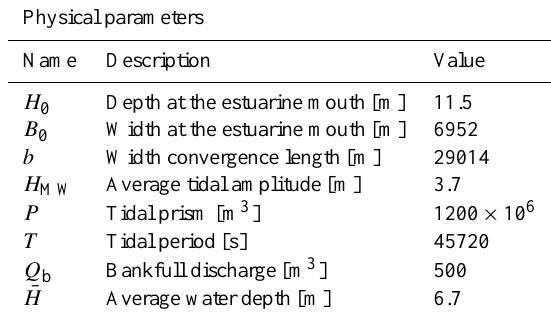
Table 2. Values for physical parameters used in C-GEM for station- ary and transient